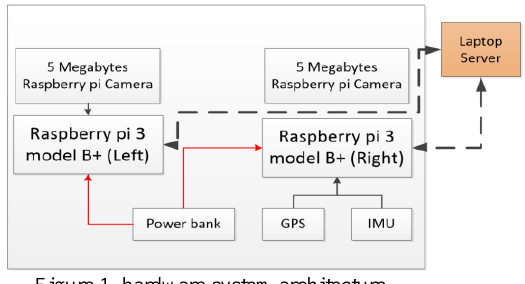
Figure 1. hardware system